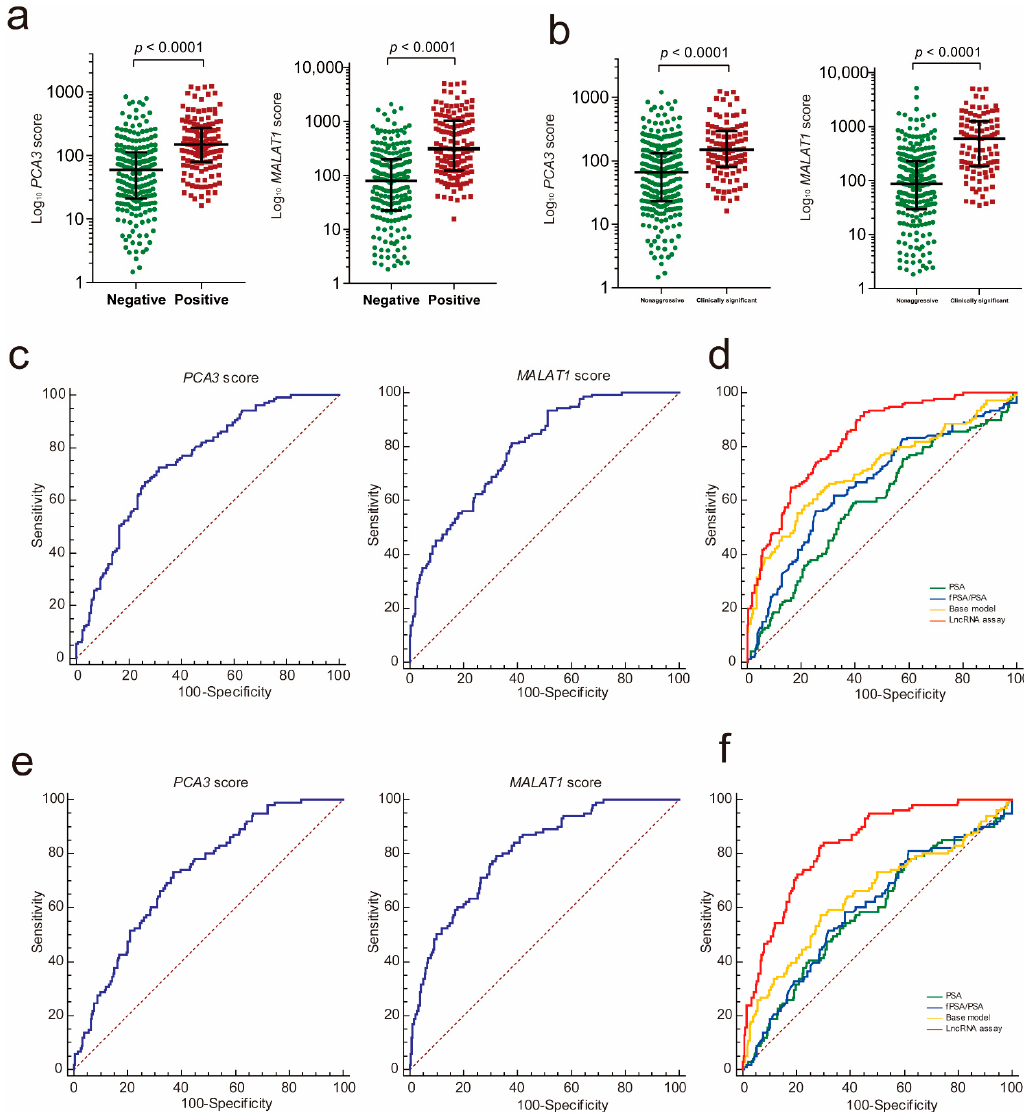
Figure 2. The lncRNA assay predicted the initial biopsy results. ( a ) Urinary exosomal PCA3 and MALAT1 were significantly